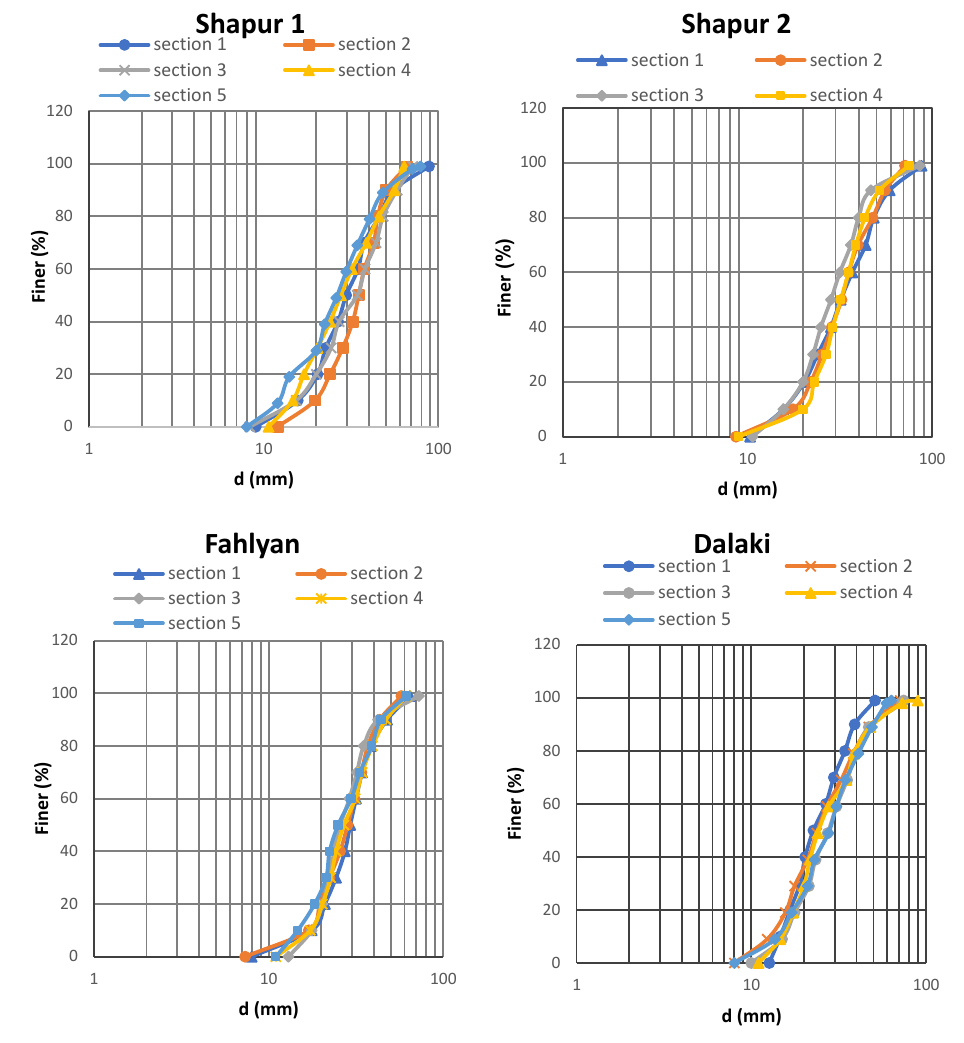
Figure 7. Grain size distribution in the studied reaches. Table 4. The number of surveyed points in studied